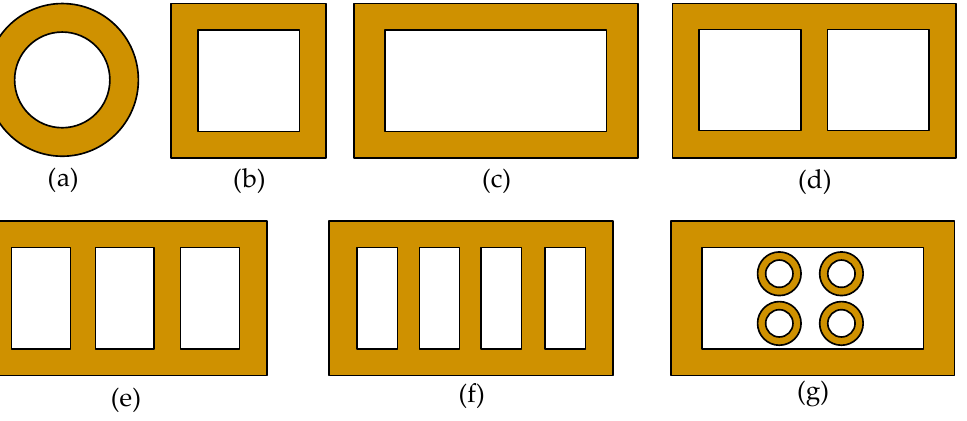
Figure 6. Magnetic coupler configurations: ( a ) circular; ( b ) square; ( c ) rectangular; ( d ) DD; ( e ) bipolar; ( f ) DDQ; ( g ) QDQ [24].